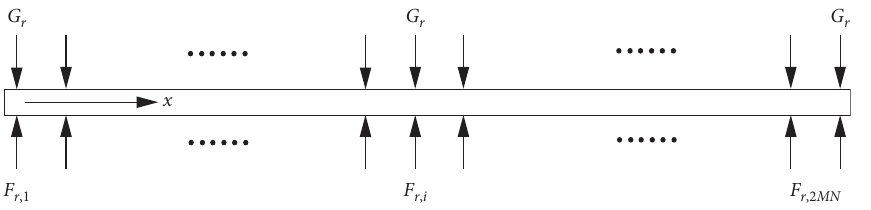
Figure 2: Forces applied on